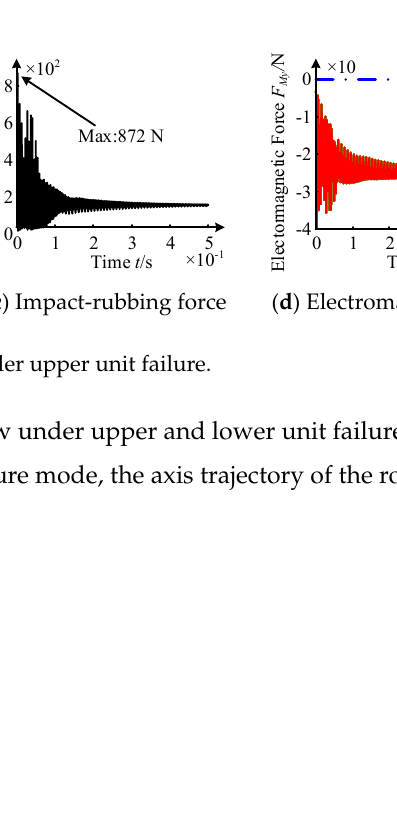
edly forward/backward.